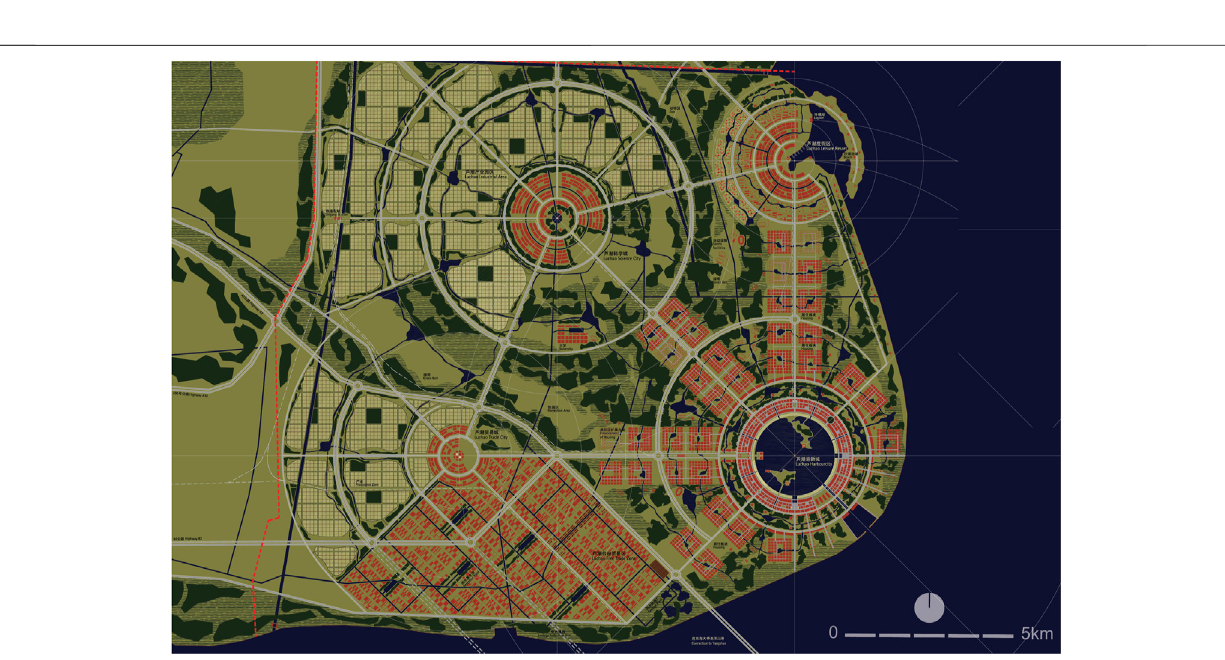
FIGURE 8| Master plan Lingang New Harbor City with 800,000inhabitantson top of122.5 squarekilometers reclaimed wetland. Only a quarter of this city and its green buffers has been realized, a large share of the buildings is empty and remaining lands have various usages, mainly farming or recreation (Source: GMP 2001; adjusted by